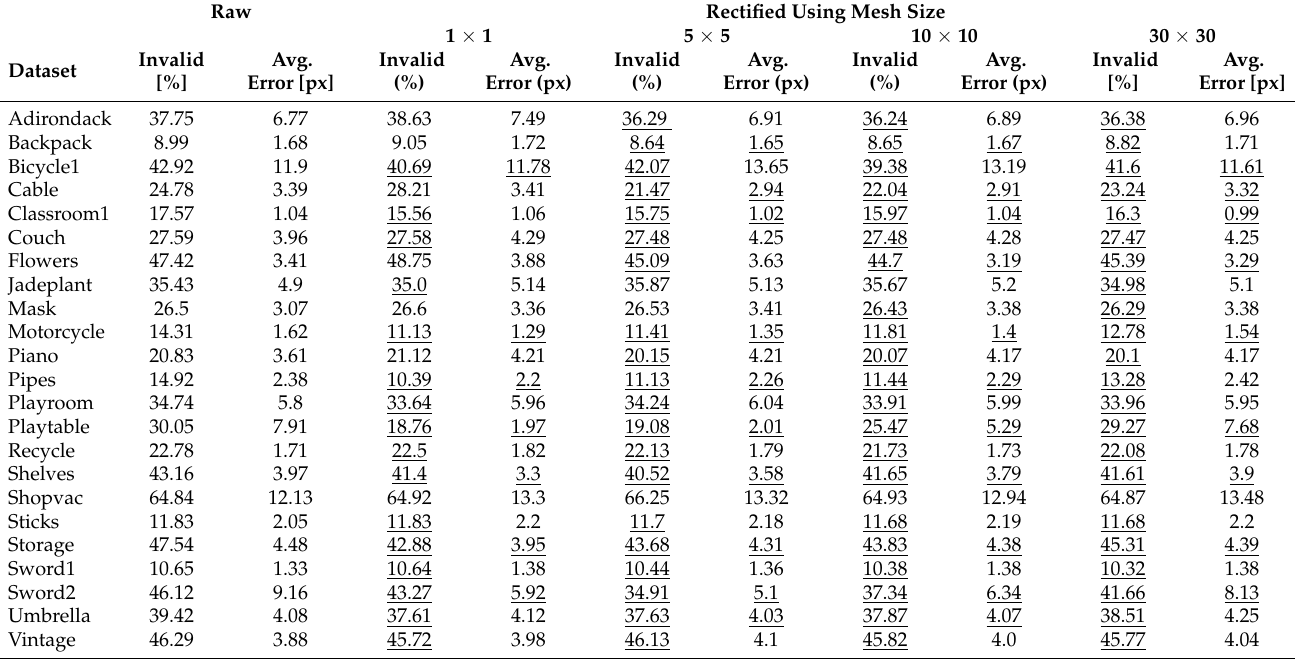
Table 1. Results of the accuracy evaluation of the proposed algorithms using the Middlebury Stereo Datasets